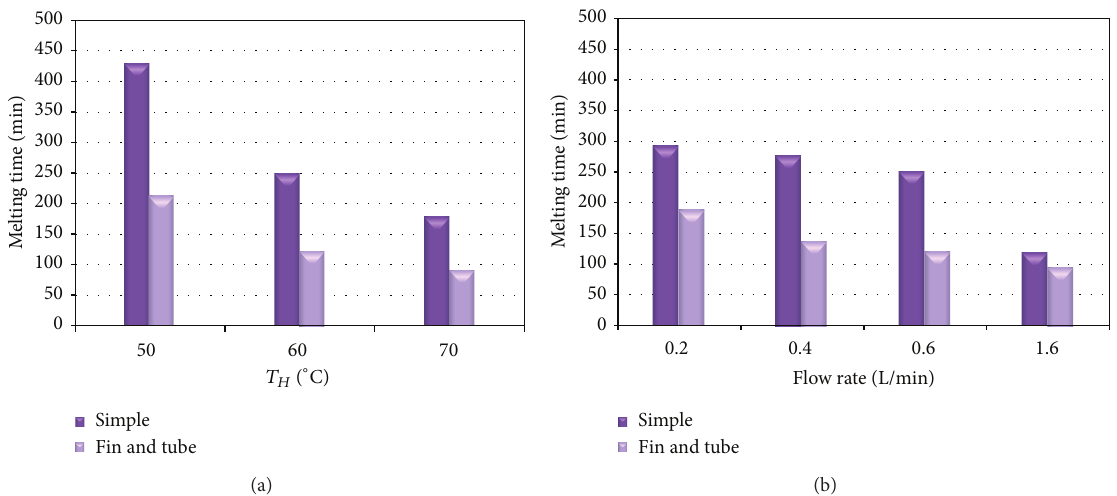
Figure 10: Comparison of melting time for the two heat exchangers studied with (a) variation of 𝑇 𝐻 (flow rate = 0.6 L/min); (b) flow rate ( 𝑇 𝐻 = 60 ∘ C).